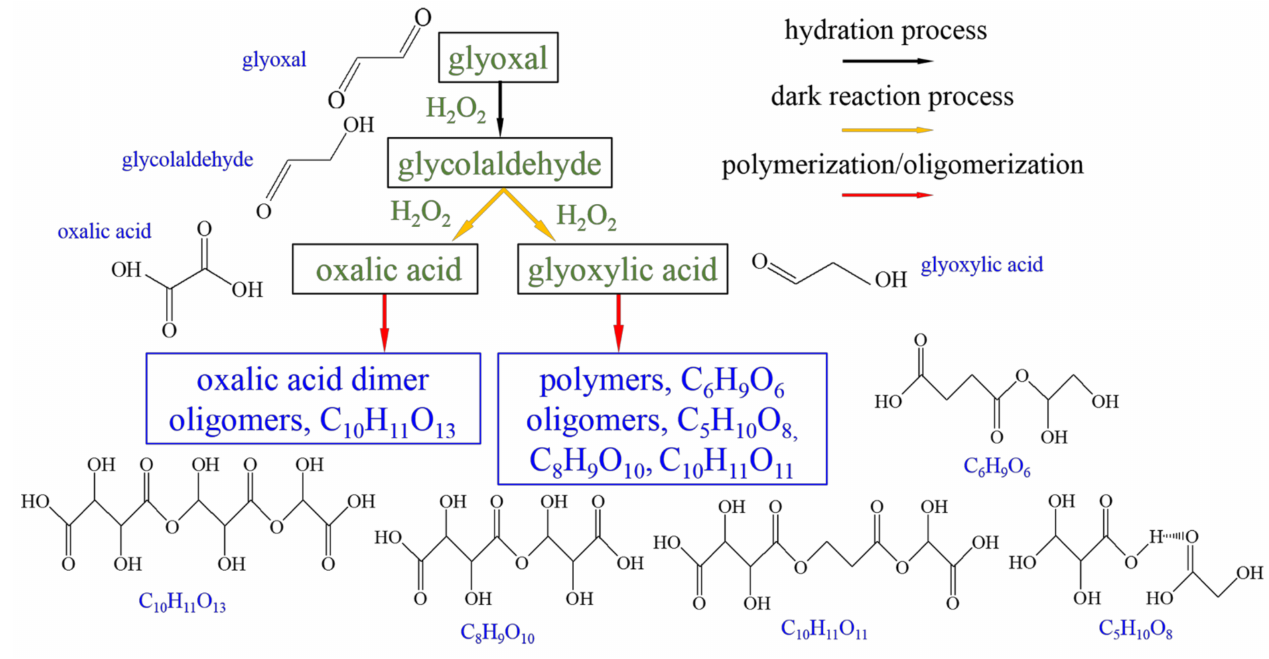
Figure 4. The expanded reaction flow chart of glyoxal dark reactions based on VUV SPI-MS results. Black arrows represent hydration process, yellow—dark reaction process, and red—polymerization/oligomerization. Green font and boxes stand for known carboxylic acids. Representative new products are highlighted in blue font and